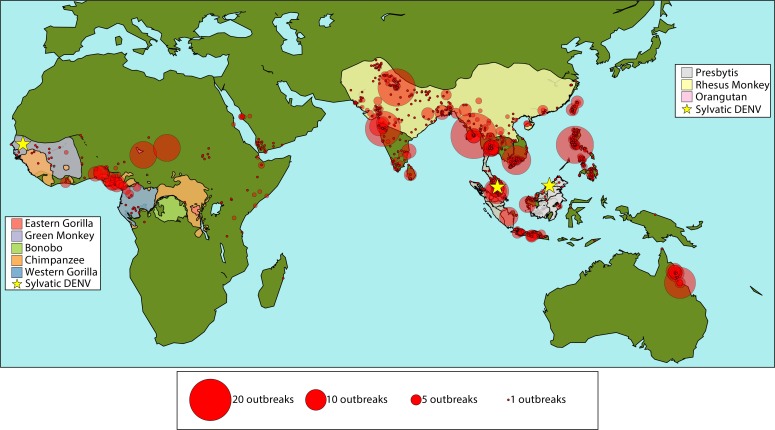
Many primate species reside in areas where dengue viruses are endemic in humans.